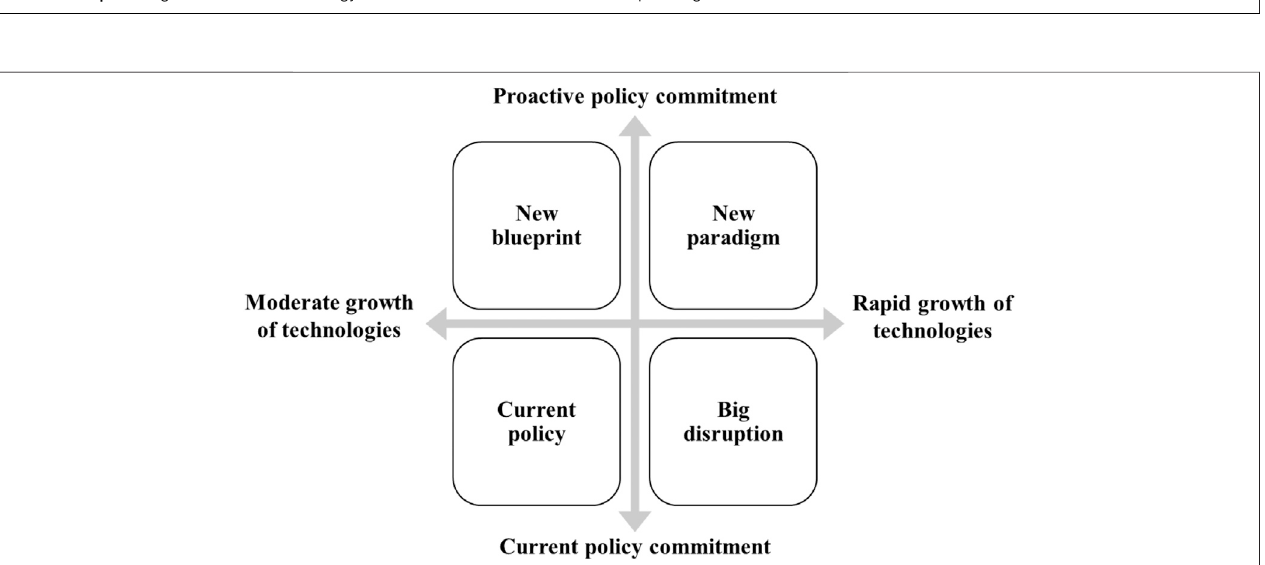
FIGURE 8 | Ranking of drivers of Thai energy business towards sustainable development goals.